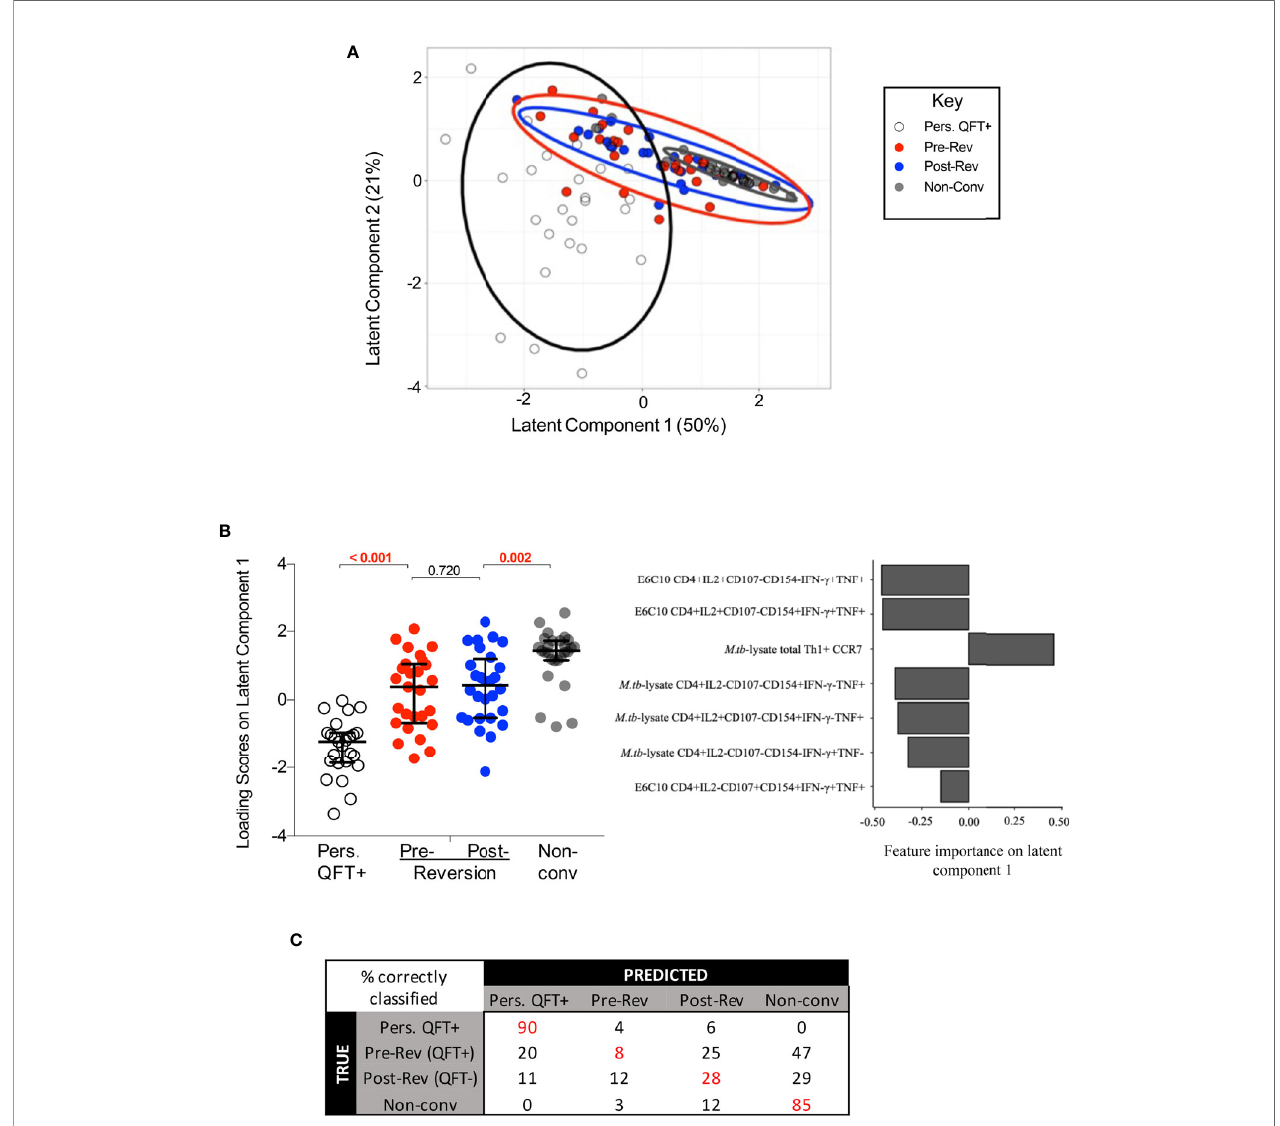
FIGURE 6 | Integrated analysis of classical T cell, innate, DURT and B cell responses to M.tb. (A) The PLS-DA biplot shows the fi rst and second latent components from the model built on LASSO-selected features. Each dot represents a participant, all participants were included (n = 30 per group). The thick line curves denote the 95% con fi dence ellipses for each group. (B) Left: loading scores of each group on latent component one, where the pre- and post- reverter groups were compared using Wilcoxon ’ s signed rank paired test and the other groups were compared using Mann Whitney ’ s U test. Right: bar graph indicating feature importance in latent component one. (C) The average confusion matrix across 1000 bootstrapped samples after a cross-validation of the PLS-DA model. Each row represents the true outcome in the testing set and each column the outcome predicted by the model. Values in red represent the % of correctly classi fi ed